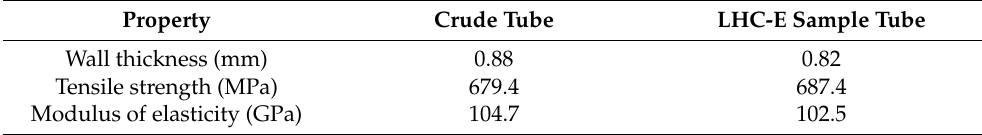
Table 5. Testing of tension before and after chemical